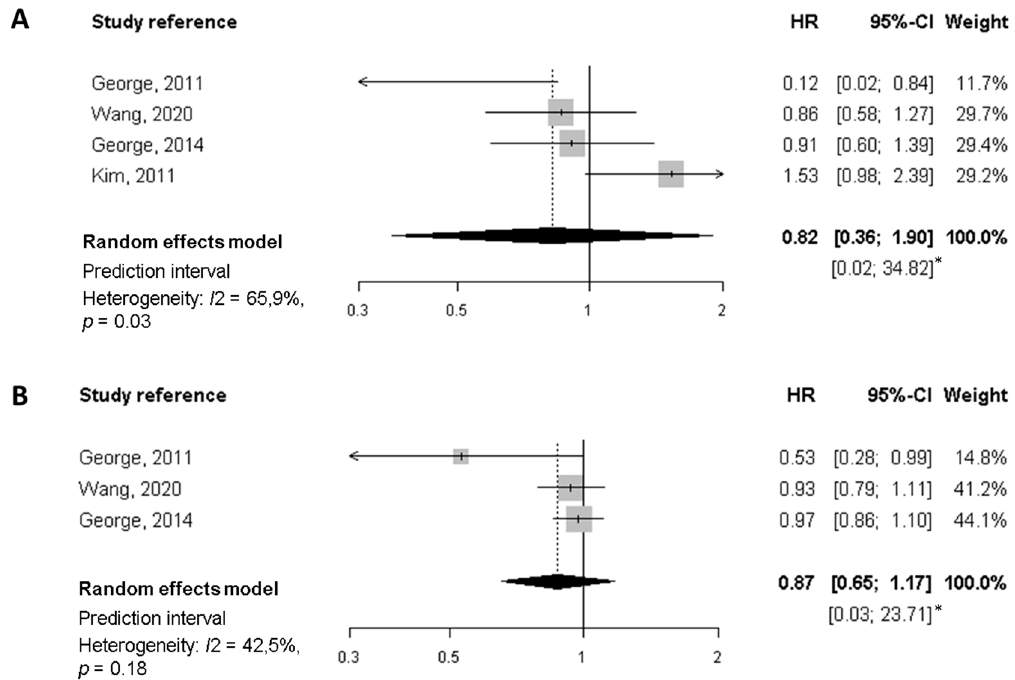
Figure 3. Meta-analysis of prospective cohort studies on the association between quality diet score and breast cancer-specific mortality among breast cancer survivors. ( A ) Forest plot showing pooled hazard ratios (HRs) with 95% CI for the highest diet quality (Healthy Eating Index [HEI], Alternate Health Eating Index [AHEI]) vs. lowest diet quality category for breast cancer-specific mortality. ( B ) Forest plot showing pooled HRs with 95% CI for 10-point increase in the quality diet score and breast cancer-specific mortality. * Prediction interval lines are not represented in this figure because intervals are too